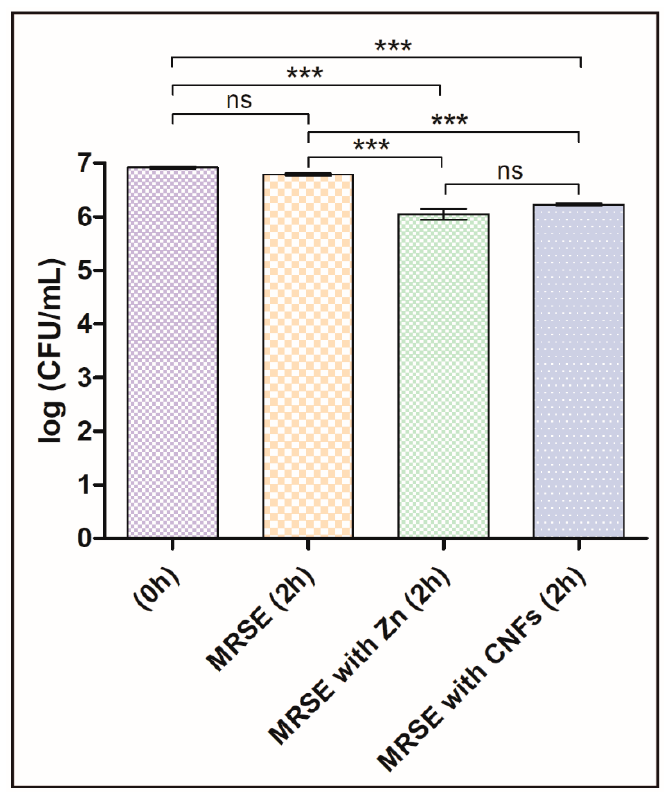
Figure 3. Multidrug-resistant Staphylococcus epidermidis (MRSE) cultured in isotonic saline solution, in isotonic saline solution with 80 µg/mL of zinc (MRSE with Zn) and in isotonic saline solution with 80 µg/mL of carbon nanofibers (MRSE with CNFs) at time zero and after 2 h of culture at 37 °C. Error bars represent standard deviation. The one-way ANOVA results are indicated in this figure. ∗ p < 0.05, ∗∗ p < 0.001 and ∗∗∗ p < 0.0001 and ns indicates “no significant difference” ( p > 0.05).